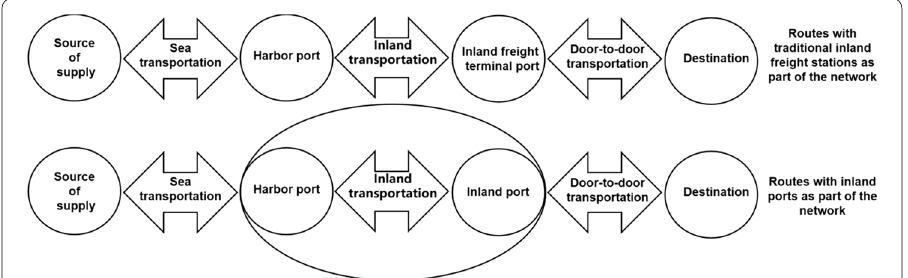
Fig. 3 Evolution of the concept of dry